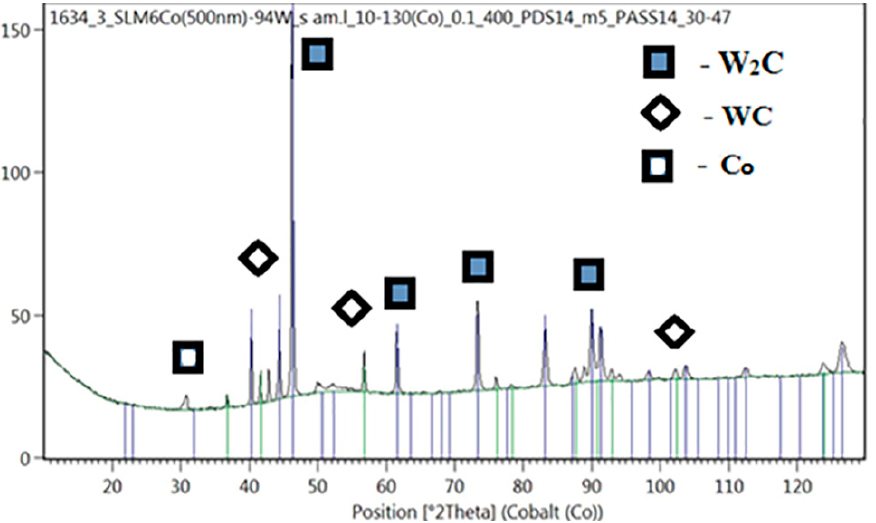
Figure 12. Diffraction spectrum of a sample of 94 wt% WC and 6 wt% Co. Figure 12. Di ff raction spectrum of a sample of 94 wt% WC and 6 wt%